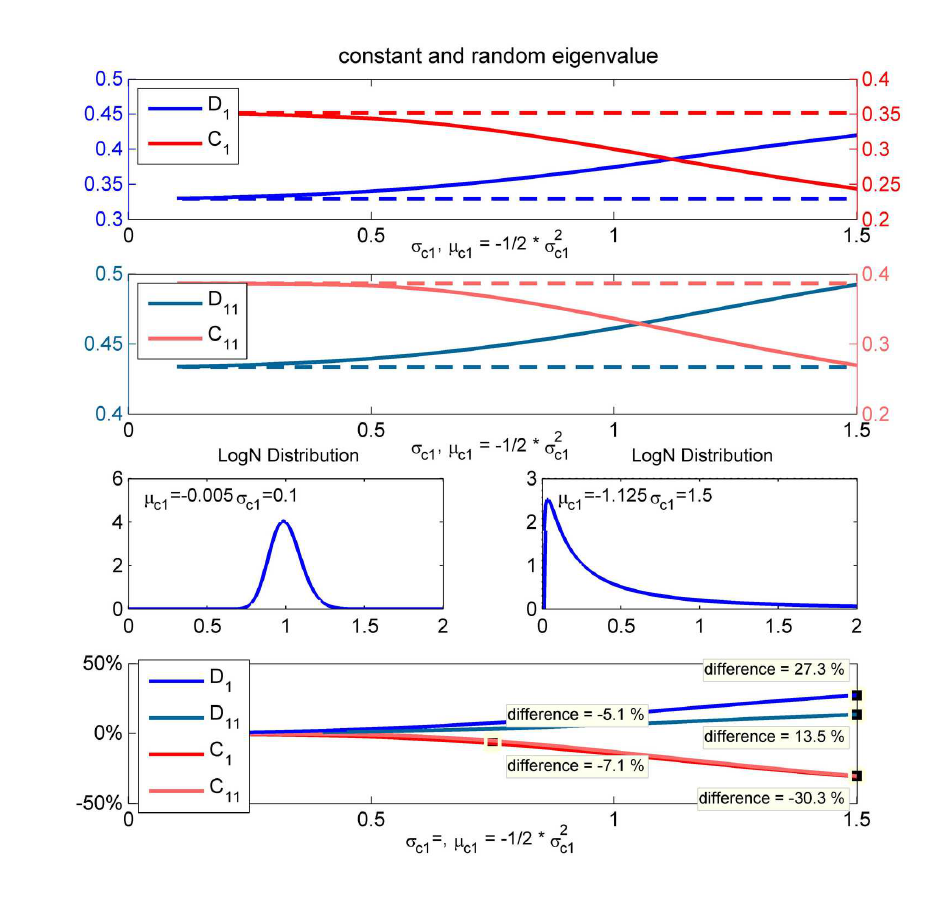
Figure 10. Effect of increasing uncertainty about one eigenvalue ( k = 1) and price differences between random and constant